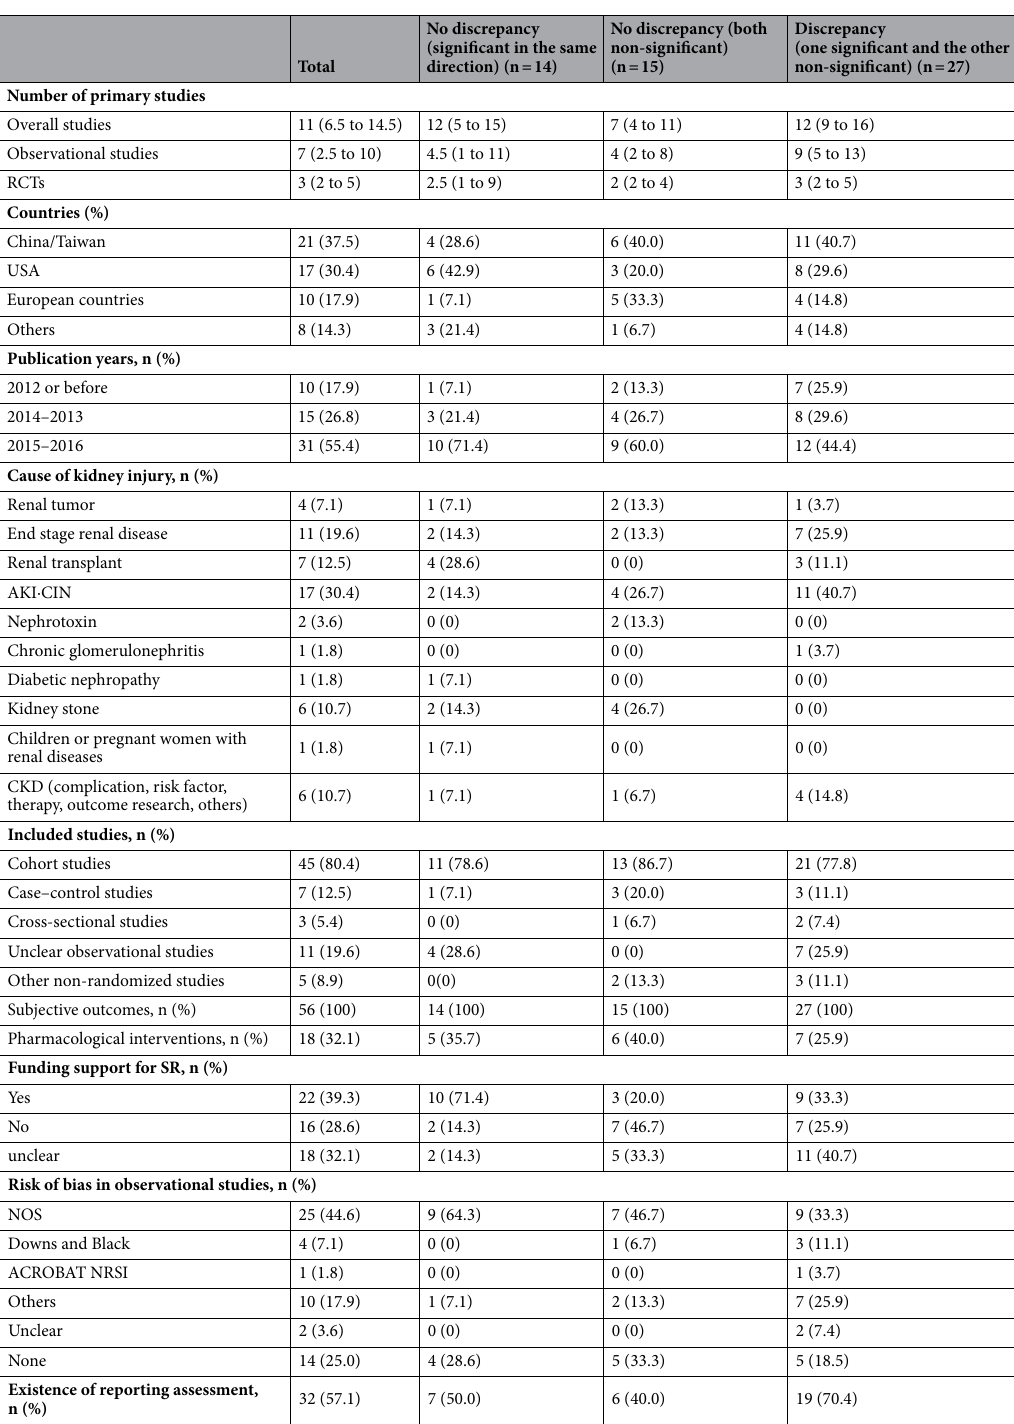
Table 2. Baseline characteristics of the 56 included meta-analyses combining both observational studies and randomized control trials. Results of continuous variables are shown as the mean (standard deviation) or median (interquartile range). RCT randomized controlled trial, USA United States of America, AKI acute kidney injury, CIN contrast induced nephropathy, CKD chronic kidney disease, NOS Newcastle–Ottawa Scale, USPSTF/Task Force The U.S. Preventive Services Task Force, ACROBAT-NRSI A Cochrane Risk of Bias Assessment Tool for Non-Randomized Studies of